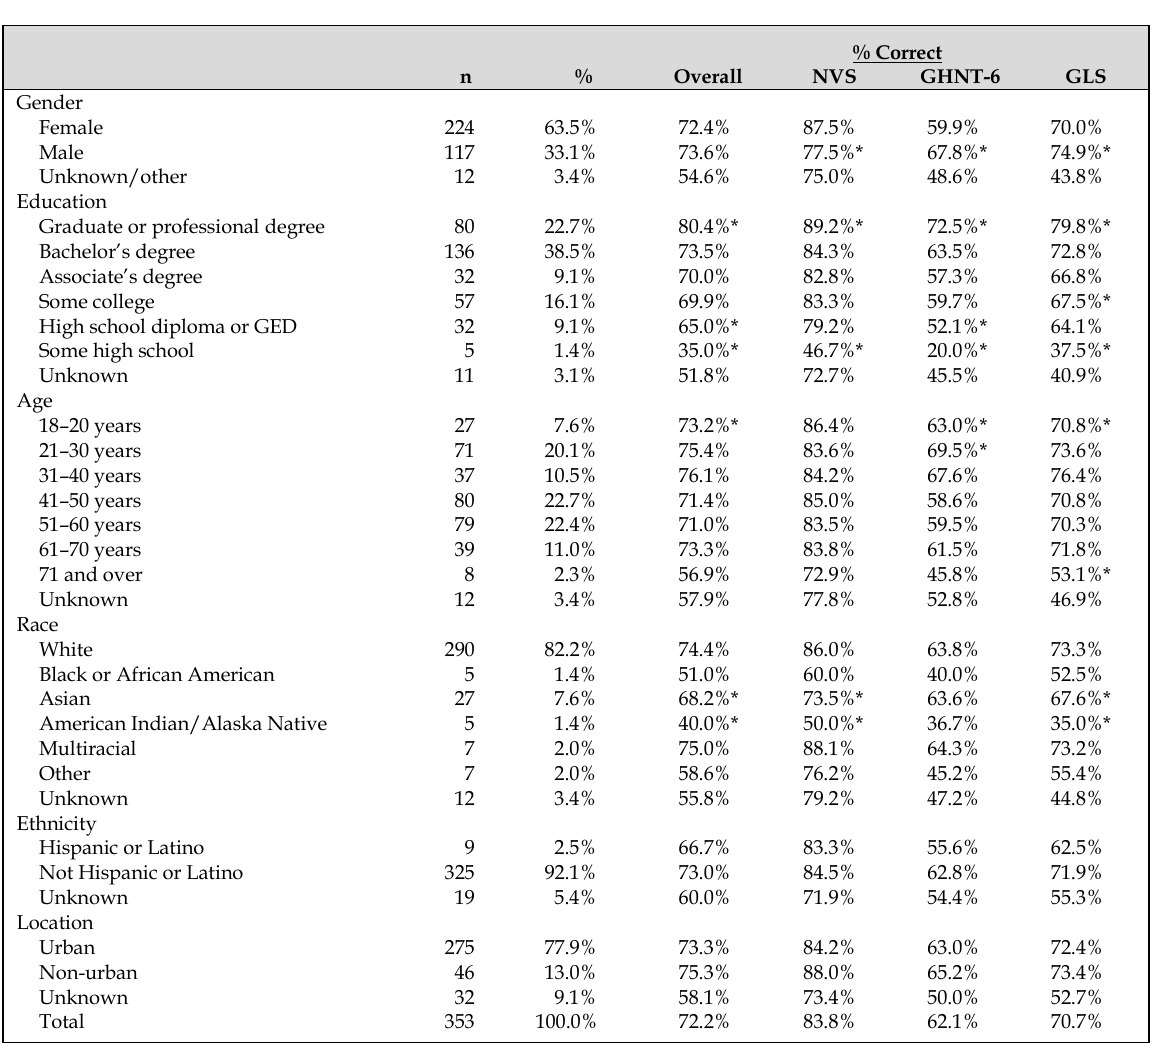
Table 1 Participant demographics and instrument